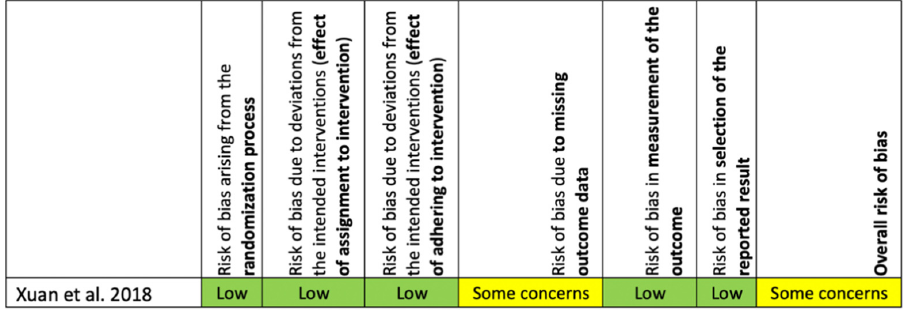
Figure 3. Risk of bias assessment for the randomized controlled trial using the Cochrane Risk of Bias (RoB 2.0) tool.